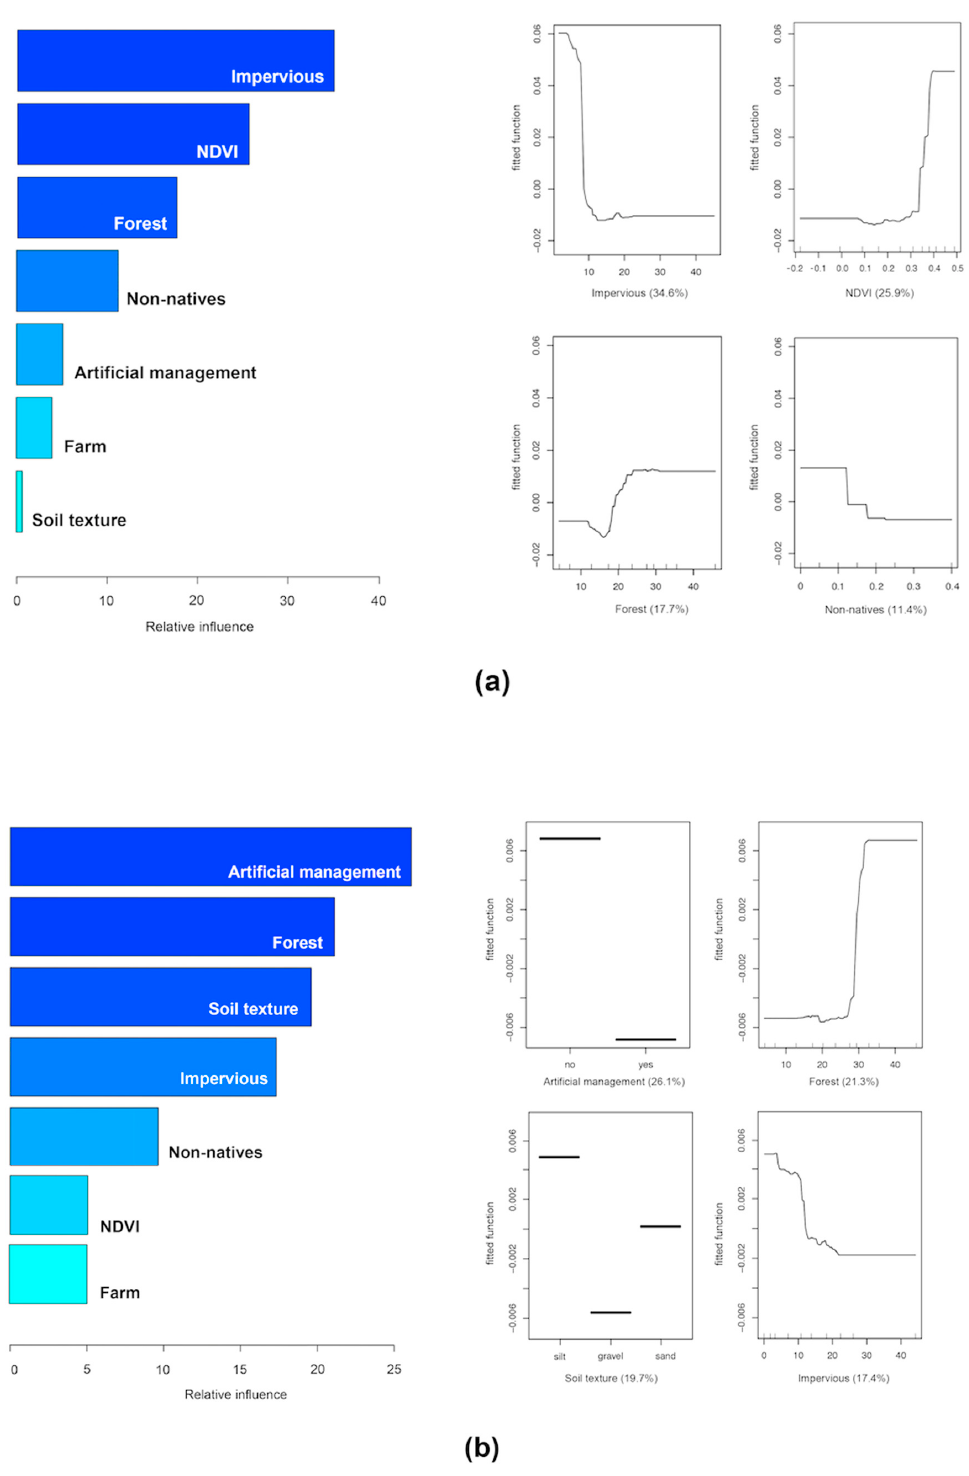
Figure 6. Relative influence of predictors and partial dependency plots for boosted regression tree analyses on taxonomic ( a ) and functional ( b ) β -diversity. For taxonomic β -diversity, explained deviance: 0.429; For functional β -diversity, explained deviance: 0.481. Numbers enclosed inside parenthesis indicated the relative importance of predictors. Notes: forest, proportion of forest cover in a 500-m bu ff er zone; impervious, proportion of impervious surface in a 500-m bu ff er zone, farm, proportion of farmland in a 500-m bu ff er zone; non-natives, the dominance of non-native species; NDVI; mean NDVI value in a 500-m bu ff er